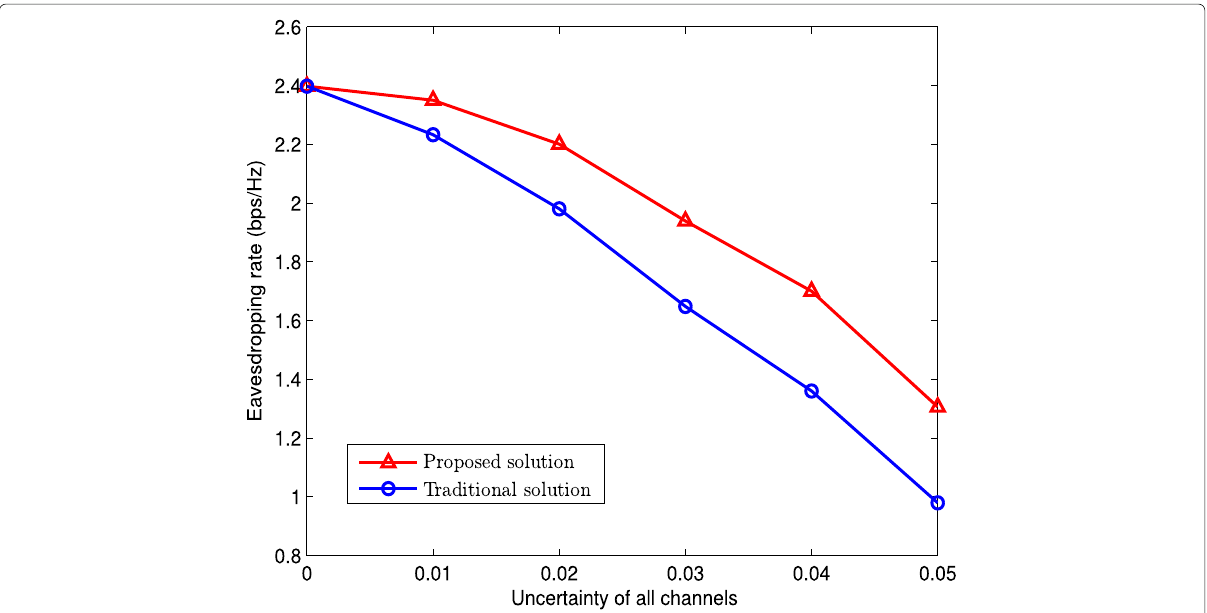
Fig. 7 Eavesdropping rate versus the uncertainty of all